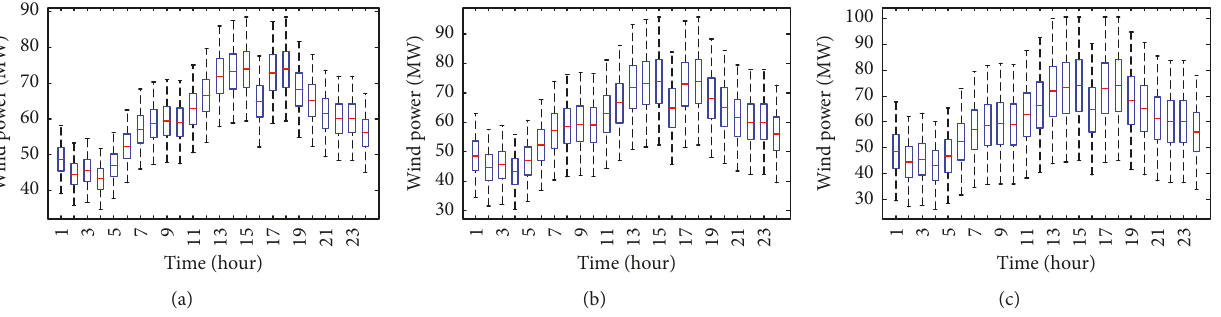
Figure 5: Boxplot for the wind power at each hour: WP error of (a) 10%; (b) 15%; and (c) 20%.